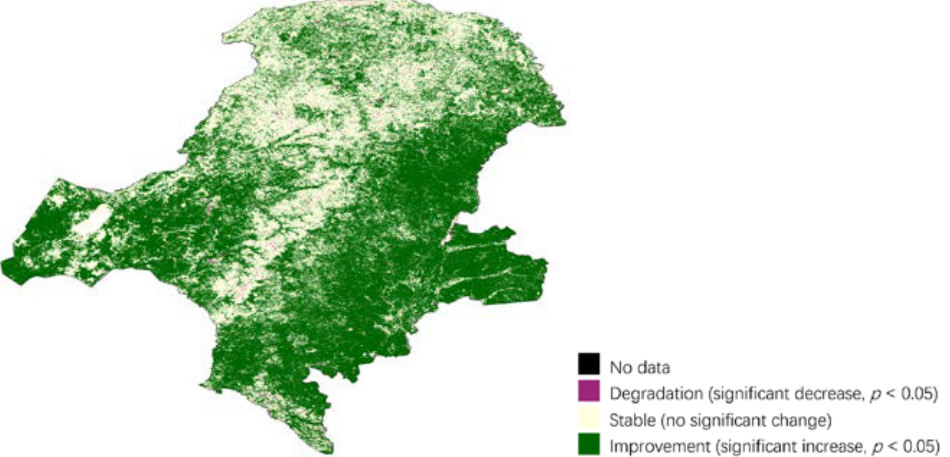
Figure 7. Productivity trajectory degradation in Great Khingan Mountain (GKM), China (2000– 2018).